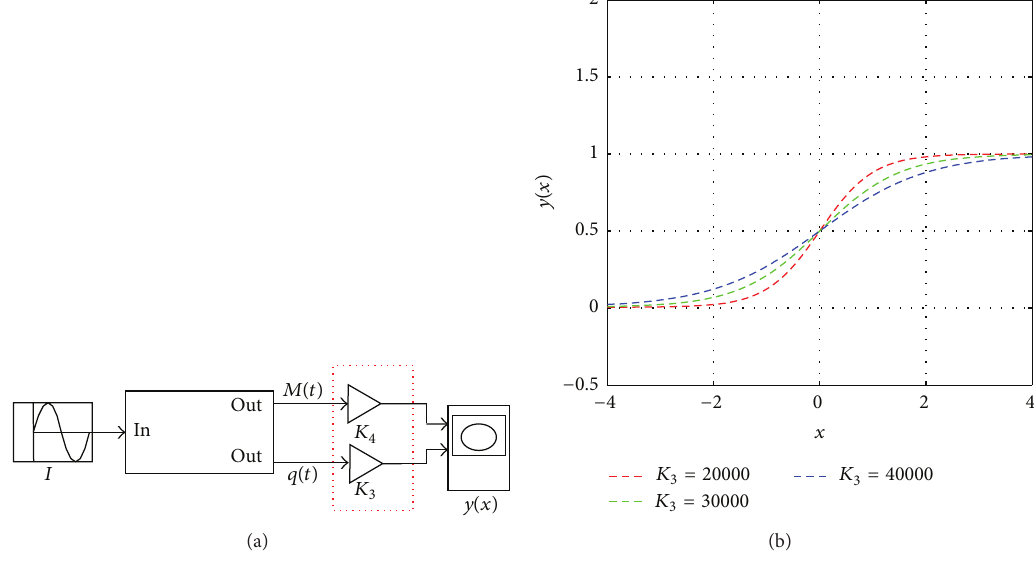
Figure 10: The principle diagram of the memristive activation function of the output layer. (a) The Simulink model of the memristive activation function of the output layer. (b) The curve of the memristive activation function 𝑦(𝑥)